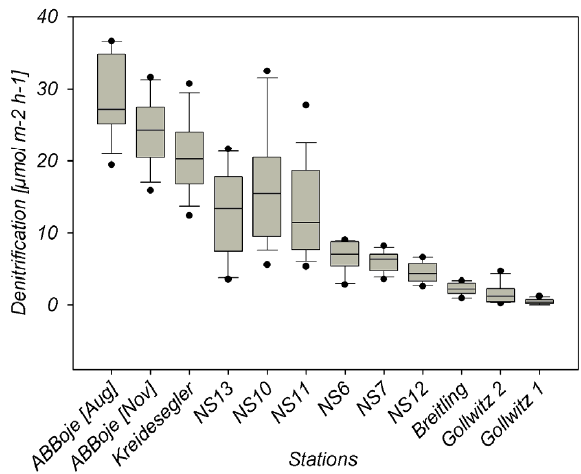
Figure 3: Box-Whisker-Plots of denitrification rates for all stations, showing median, lower Fig. 3. Box-Whisker-Plots of denitrification rates for all stations, and upper quartile, extremes, and outliers. showing median, lower and upper quartile, extremes, and